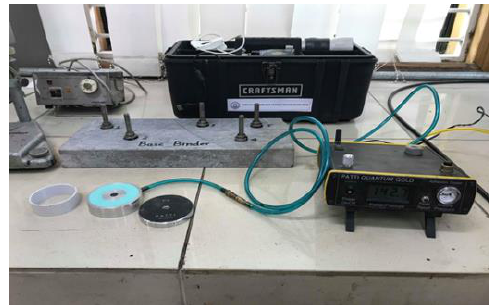
( c ) Figure 13. The bitumen/aggregate affinity after 72 h of rolling: ( a ) The base binder, ( b ) 2% Graphene Nano-Platelet (GNP)-modified binder and, ( c ) 4% GNP-modified binder. 3.6. Bitumen Bond Strength